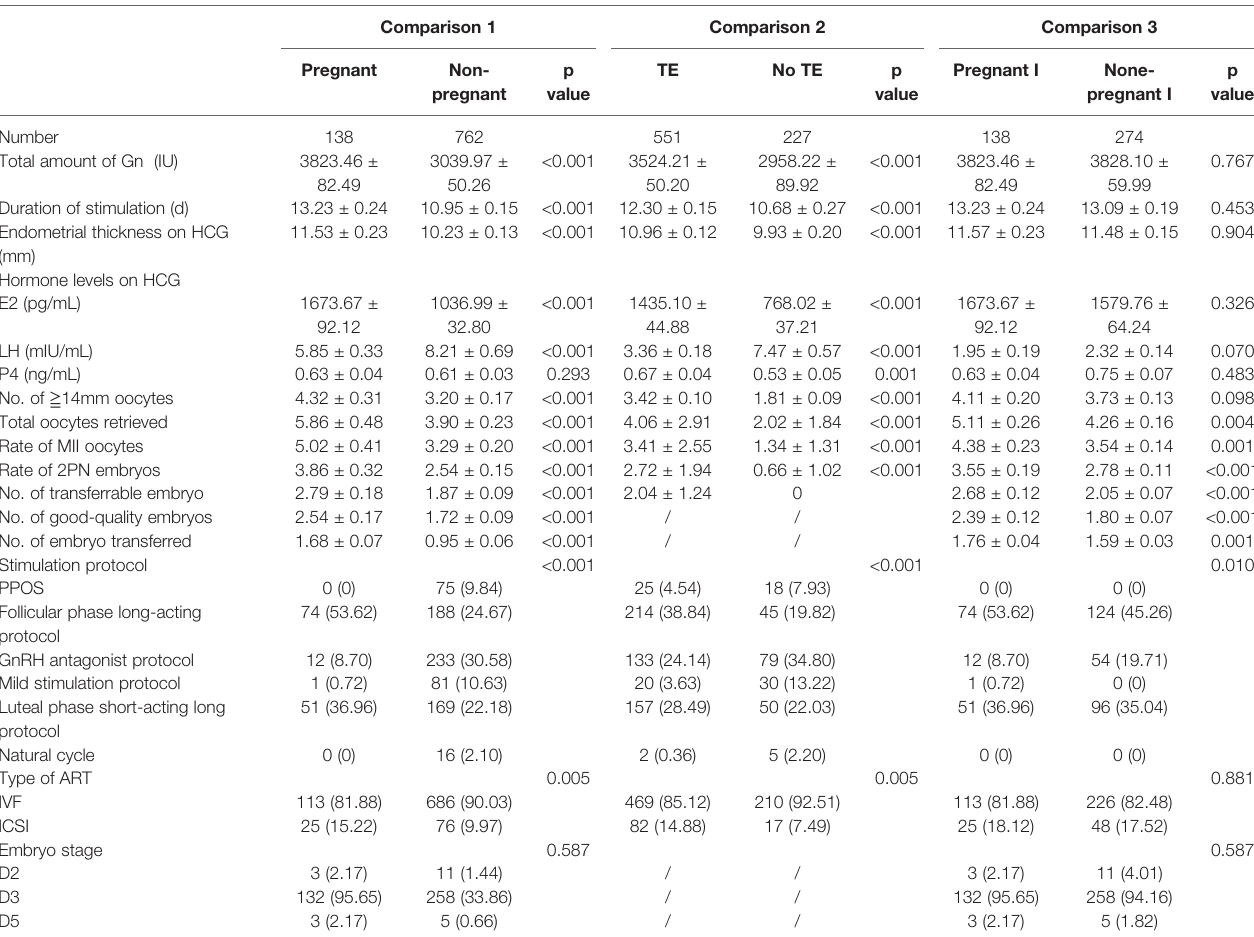
TABLE 2 | Ovarian stimulation characteristics between groups of women with DOR undergoing